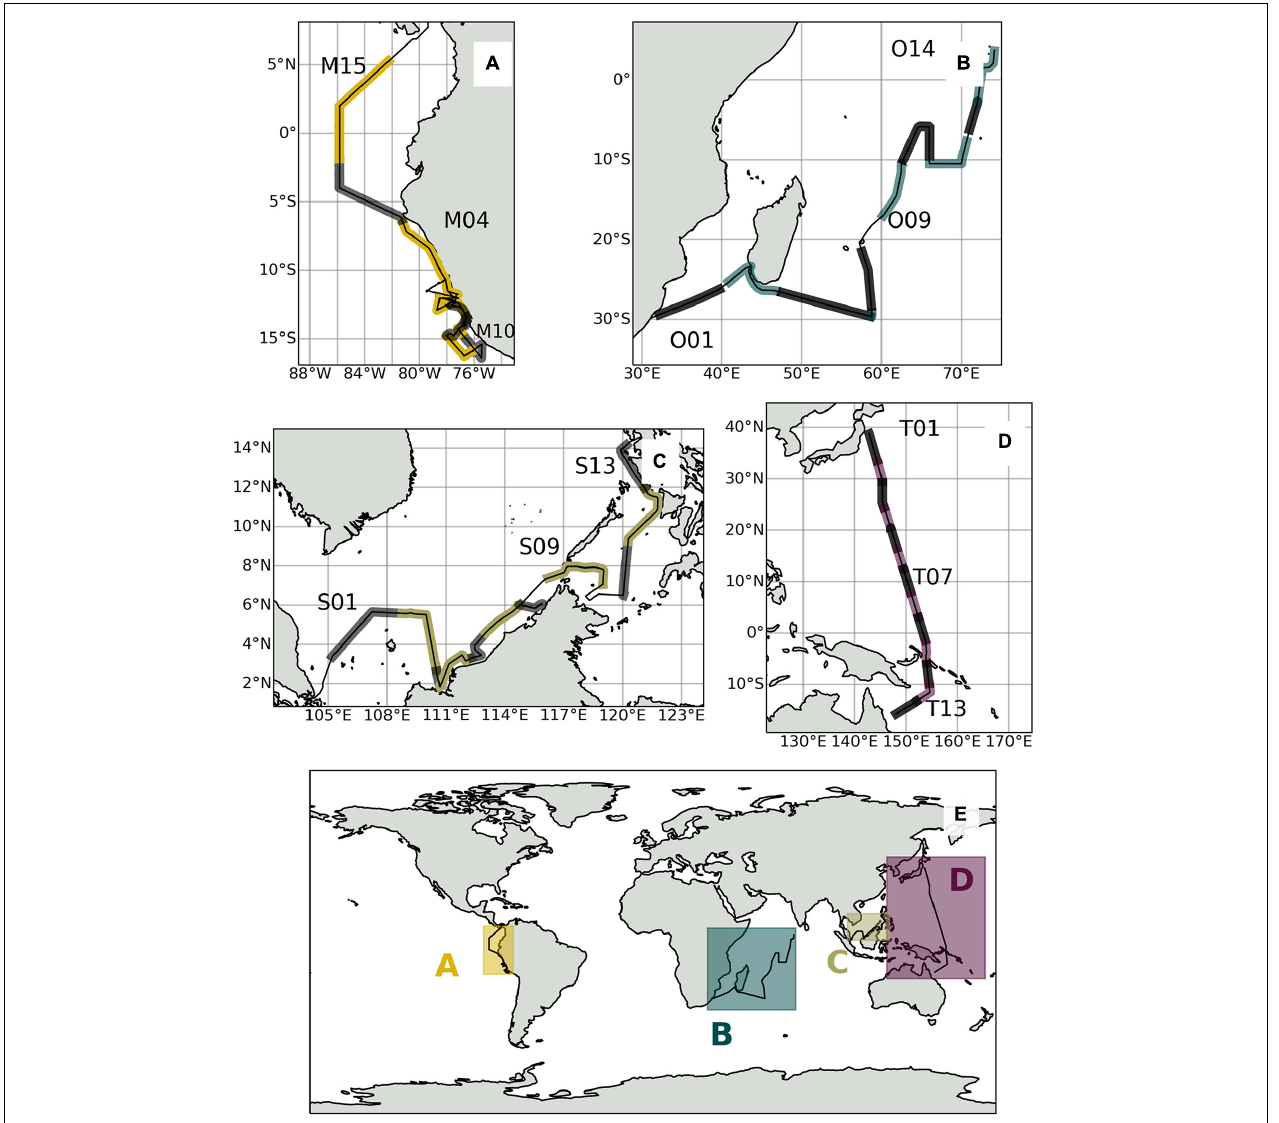
FIGURE 1 | (E) Global overview map of expedition tracks and sampling locations shown in alternating lighter and darker shades for (A) M138, (B) OASIS, (C) SHIVA, and (D) TransBrom.